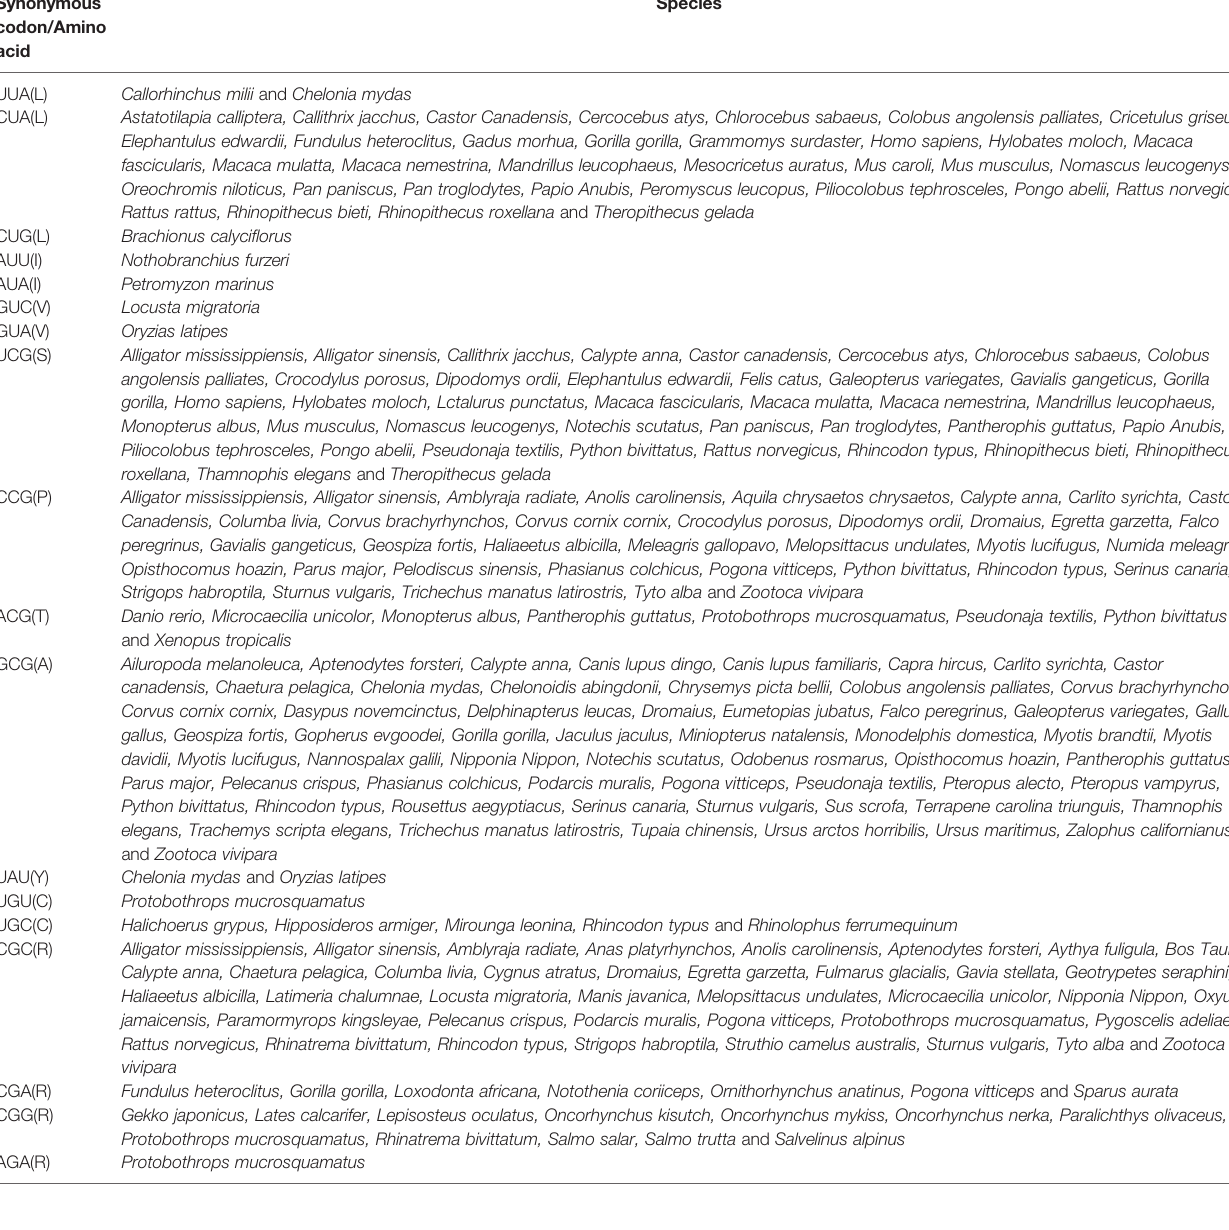
TABLE 2 | Some synonymous codons are absent from atg13 genes from different